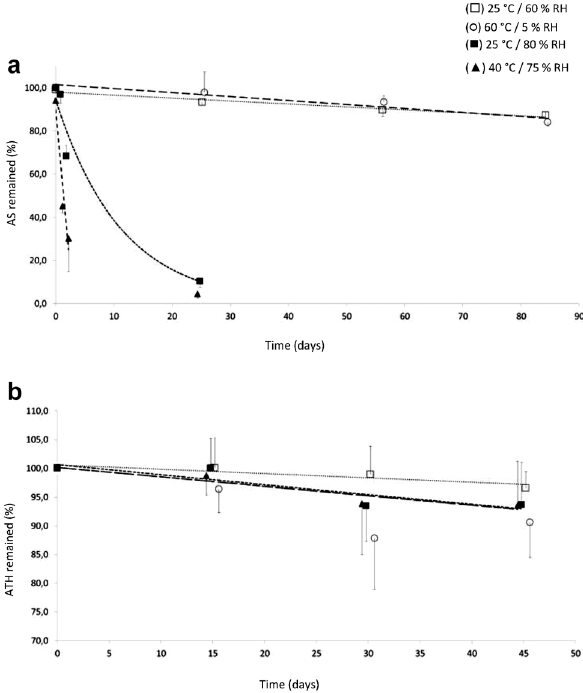
Figure 3: Degradation profiles of AS (Figure 3A) and ATH (Figure 3B) from dosage forms stored at ( □ ) 25 ° C / 60% RH ( ○ ) 60 ° C / 5% RH ( ■ ) 25 ° C / 80% RH; and ( : ) 40 ° C / 75% RH. Each data is the mean ± standard deviation of fi ve experimental determinations.